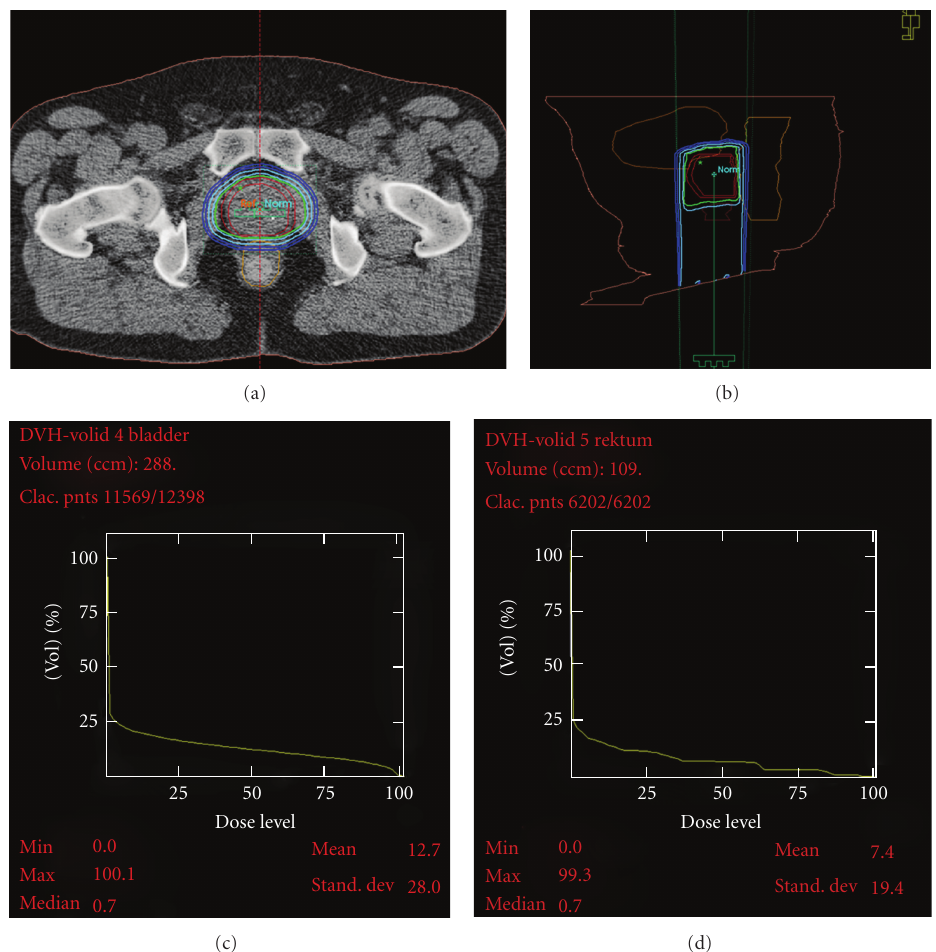
Figure 1: The planned dose distribution (panel a, b) for a patient receiving proton boost when using the rectal retraction rod and with dose volume histograms for bladder and rectum (panels c, d). The isodose levels shown are 95%, 90%, 70%, 50%, and 30%. The outer wall of the rectum is drawn by a yellow